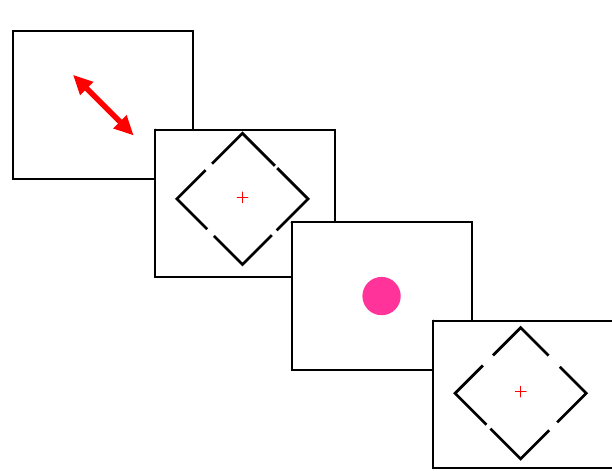
Figure 1. A schematic illustration of the sequence of events. Each block of trials began with a diagonal arrow that indicated the locations the par- ticipant was expected to attend. The color of this arrow was either green (indicating a block of easy judgments) or red (indicating a series of diffi cult judgments, as shown here). Subsequently, the participant observed a series of blue diamonds. The participant was requested to make a decision regard- ing whether the top or bottom gap was larger by pressing an upper or lower button. Note that each diamond included two pairs of gaps: an easy pair and a diffi cult pair, so the visual stimuli were identical on the easy and diffi cult blocks, with only the initial diagonal arrow indicating whether the partici- pant was comparing the easy or diffi cult pair. Occasionally, a bright fuchsia- colored circle interrupted the stream of diamonds. The participant was asked to ignore these